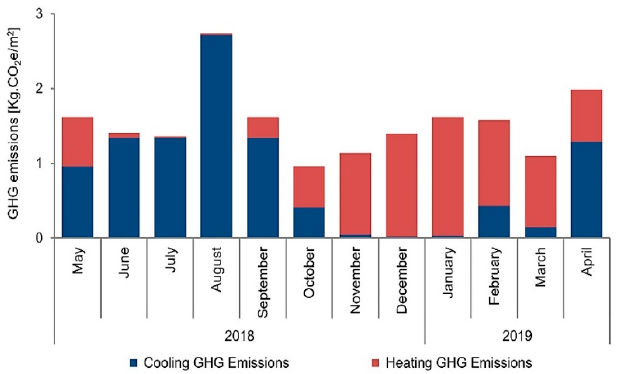
Figure 10. Total monthly GHG emissions (kg.CO 2 e/m 2 ) from May 2018 to April 2019 with cooling and heating GHG emissions.